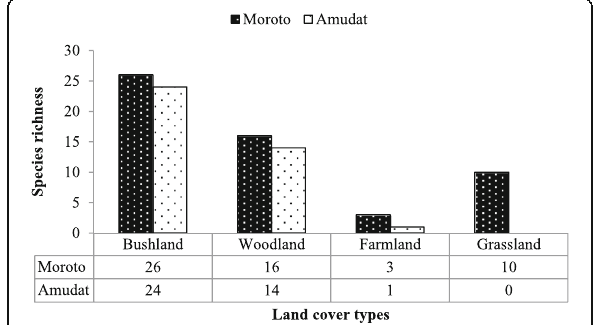
Figure 3 Species richness in the land cover types